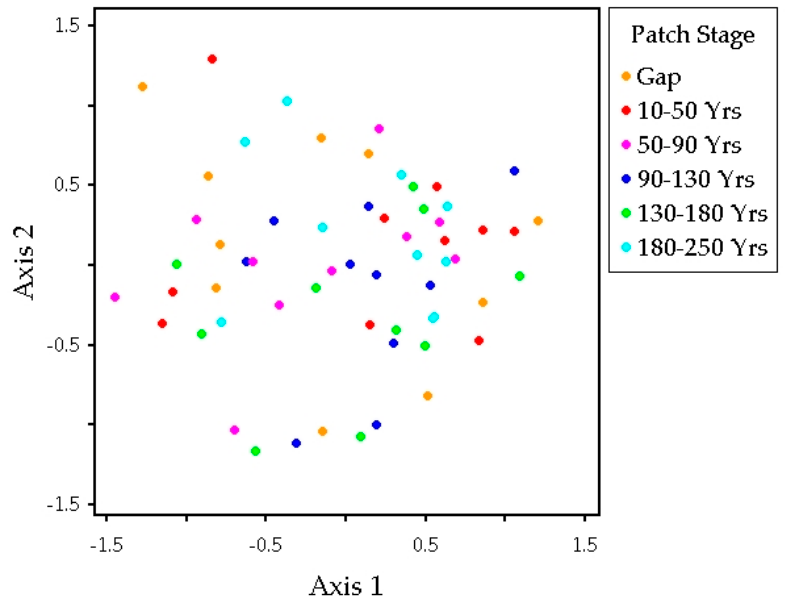
Figure 8. NMDS ordination graph of ground-layer plant species’ relative cover in plots of each of the patch stages ( n = 10). Each point is a plot of a patch, with color denoting its corresponding stage. Some genera were related to patch stages representing intermediate age classes of trees. In the family Fabaceae, seven out of its 26 species ( Centrosema virginianum Benth., Desmodium ciliare Muhl ex. Willd, D. lineatum Gray, D. marilandicum Kuntze, Galactia volubilis Britton, Lespedeza angustifolia Elliot, and L. repens Barton) were significantly associated with stage groupings incorporating the